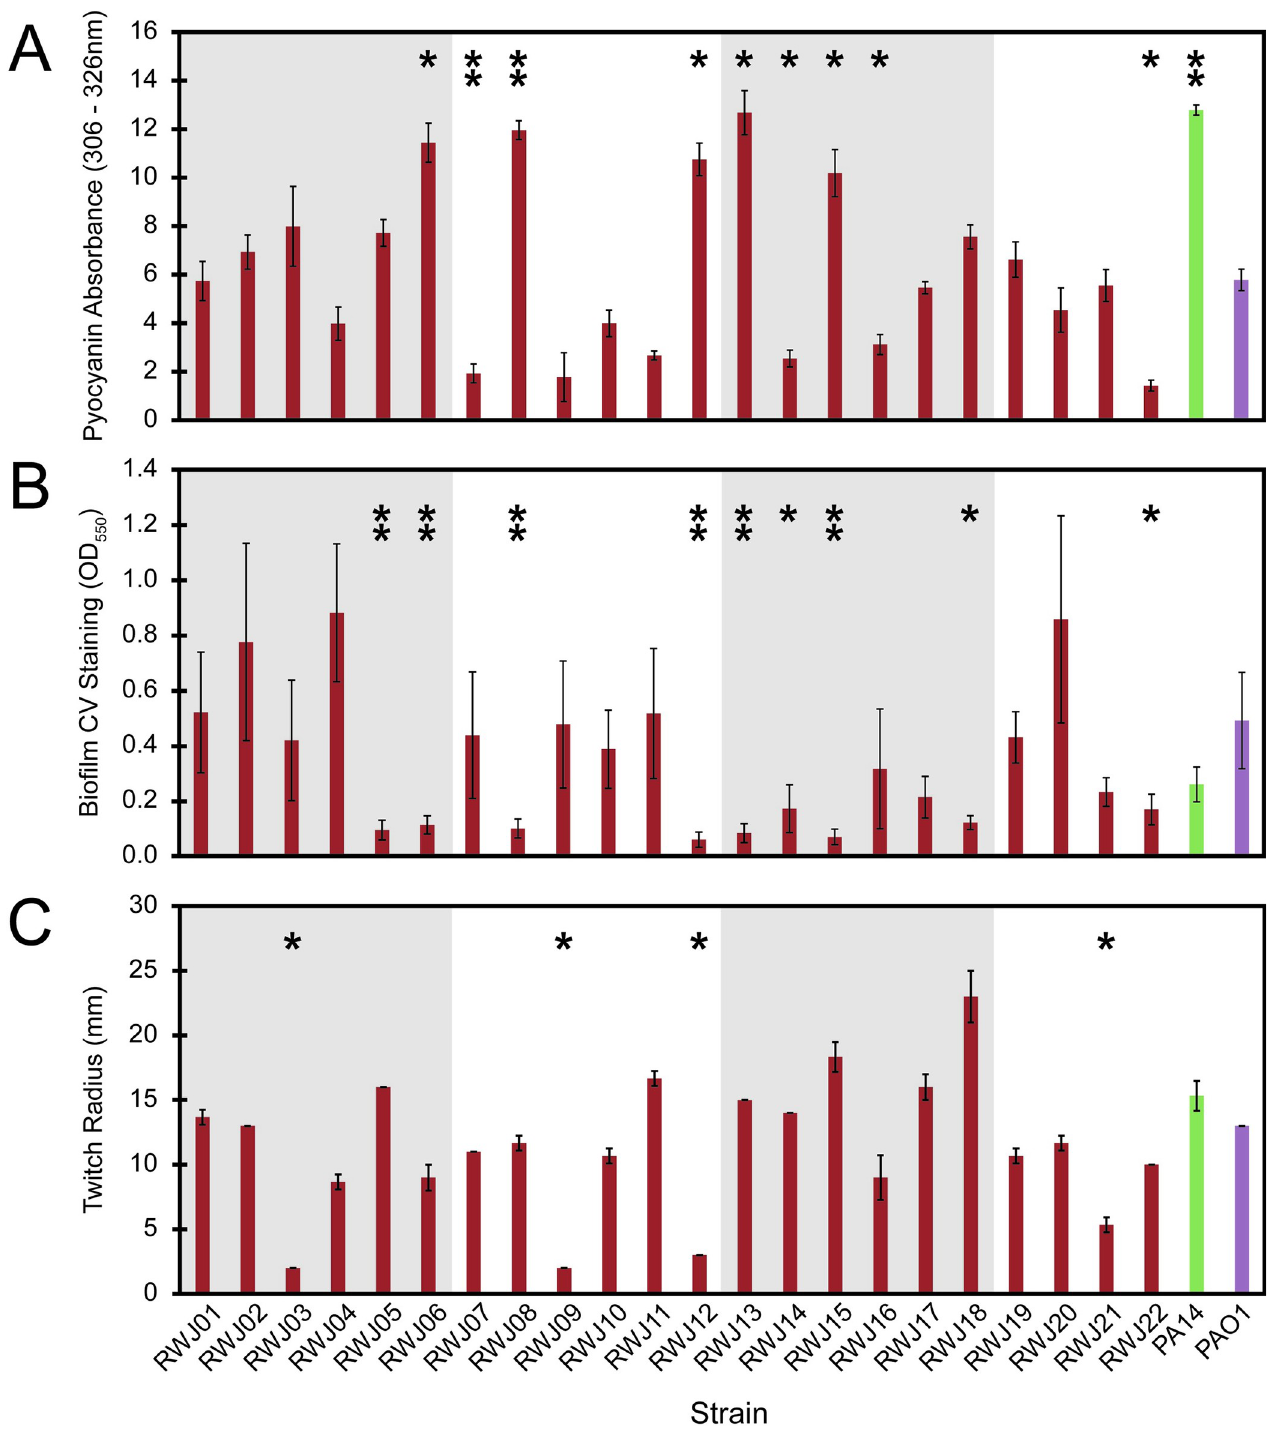
Fig 1. Virulence phenotype assays vary widely across 22 Pseudomonas aeruginosa bloodstream strains. (A) Pyocyanin absorbance integrated from 306–326 nm. Mean and standard deviation shown from 3 biological replicates (B) Crystal violet staining of total biofilm production as determined by absorbance at 550 nm. Mean and standard deviation shown from 3 biological replicates. (C) Twitching radius determined after crystal violet staining, measured in mm. Mean and standard deviation shown from 3 biological replicates. A Student’s T-test with the Bonferroni correction was used to determine statistical significance (p adj < 0.05 � , p adj < 0.01 �� ). Strains were obtained from Robert Wood Johnson medical school and are listed as RWJ01-RWJ22 and colored in red. Reference lab strains show are PA14 (green) and PAO1 (purple).